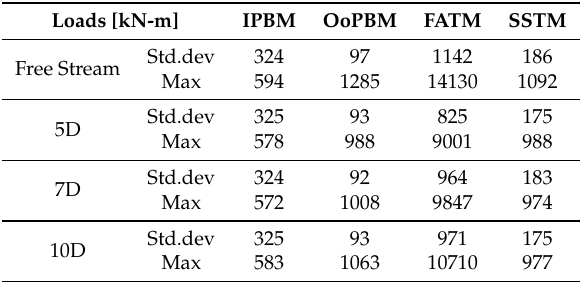
Table 15. Turbine load statistics in the wake: LES